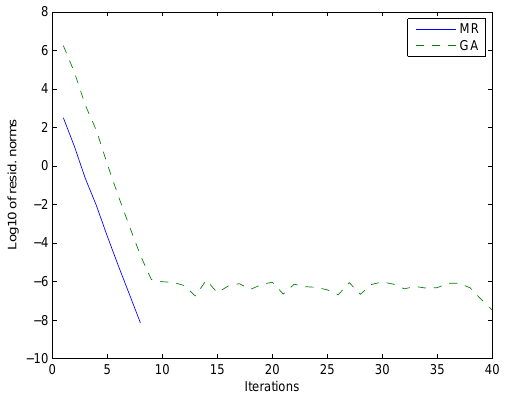
Figure 3. GA: dashed line, MR: solid